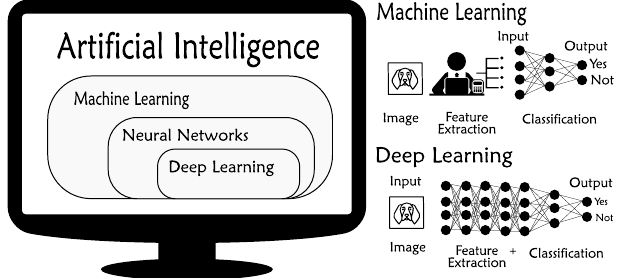
Figure 1. Relationship between Artificial Intelligence, Machine Learning and Deep Learning.